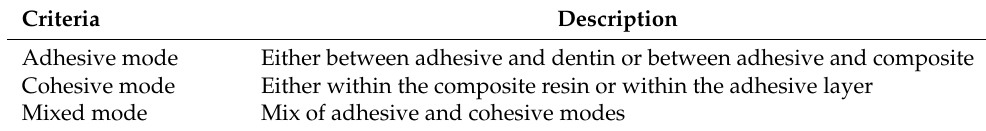
Figure 2. The bonding jig ( a ) and the application of the final 1 mm of composite increment perpen- dicular to dentin surface ( b – d ). Table 2. Classification of failure